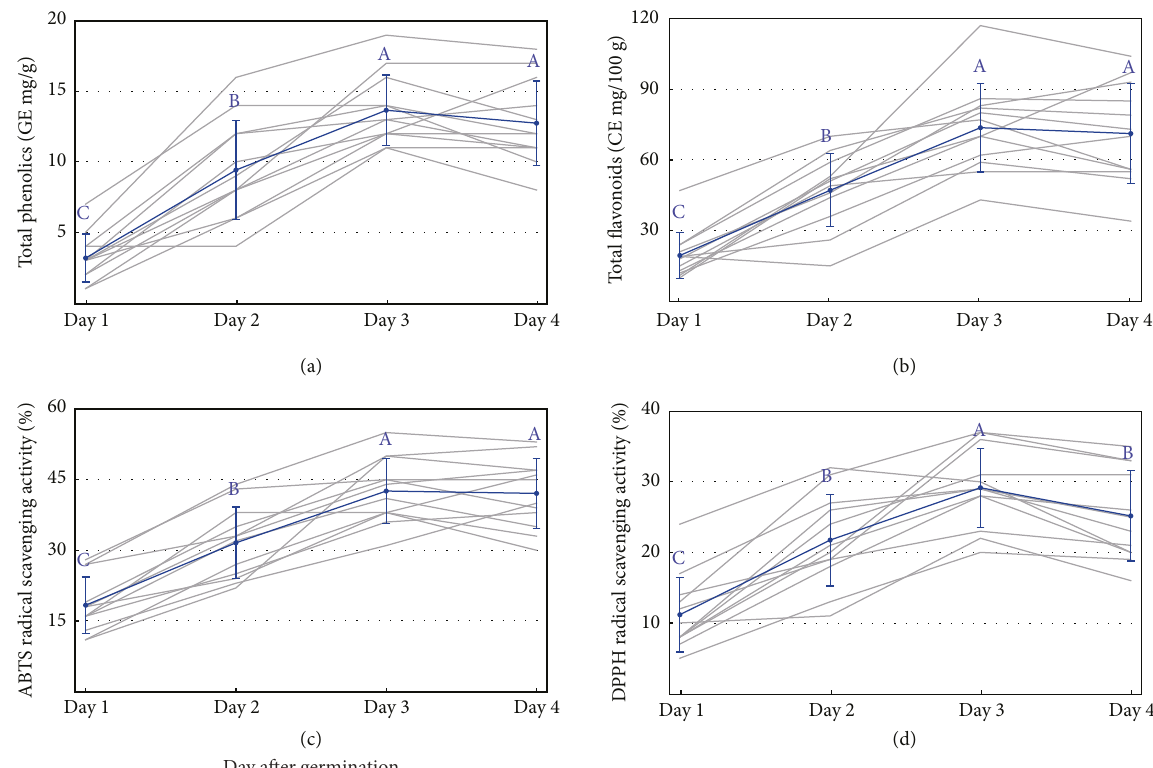
Figure 2: Changes of total phenolic and flavonoid contents, and antioxidant activity in mung bean sprouts. (a) Total phenolics, (b) total flavonoids, (c) ABTS radical scavenging activity, and (d) DPPH radical scavenging activity. The cluster analysis was performed by the K- means method. The blue lines are representative of trends in each assay, and results with different uppercase letters indicate statistical significance ( P < 0 .